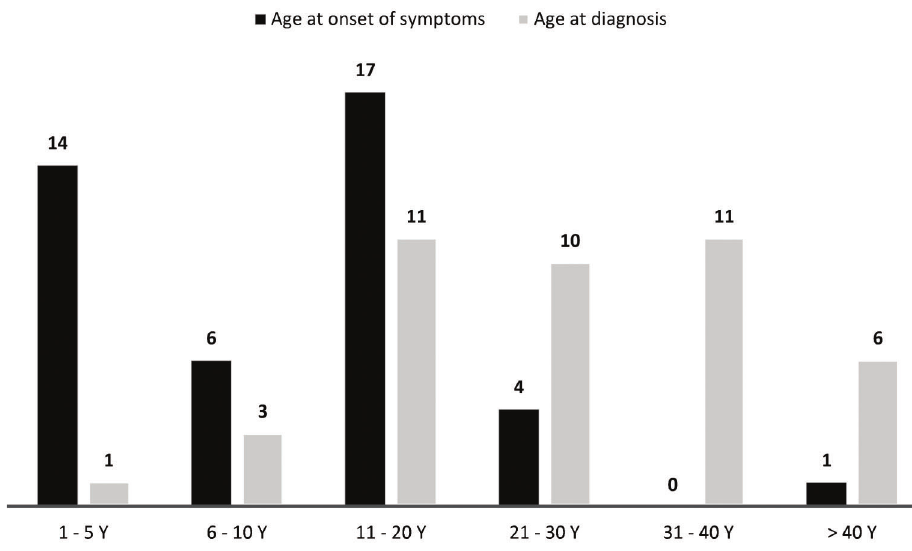
Figure 1 . Age at the onset of symptoms and diagnosis of hereditary angioedema. Y: